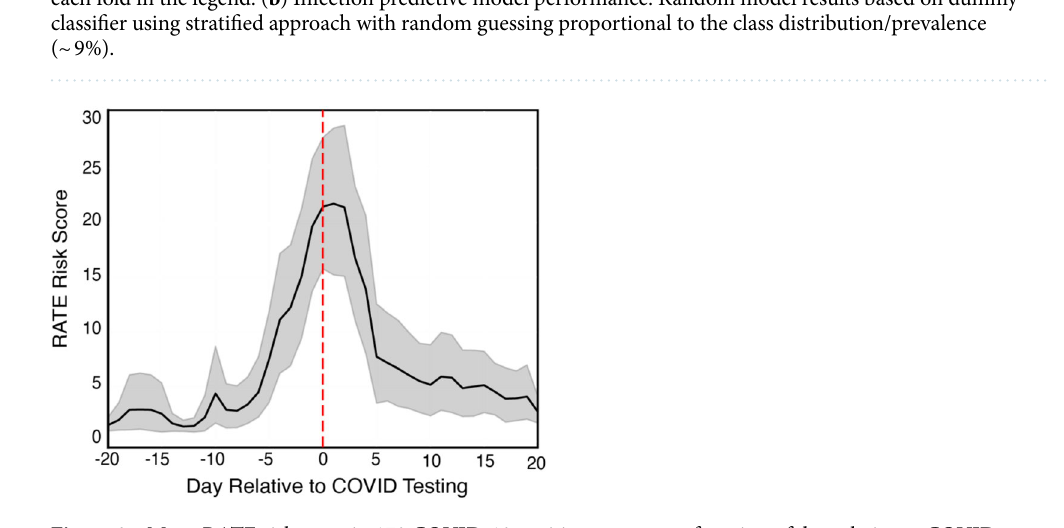
Figure 9. Mean RATE risk score in 179 COVID-19 positive + users as a function of day relative to COVID testing (red line). Grey region depicts 95% confidence interval (standard